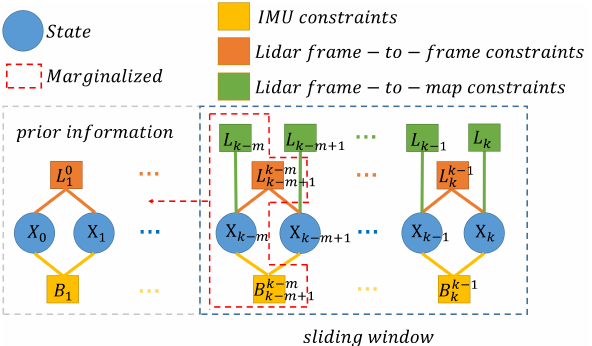
Figure 6. Illustration of the factor graph and the marginalization strategy. The oldest frame in the sliding window will be marginalized into prior information after optimizing